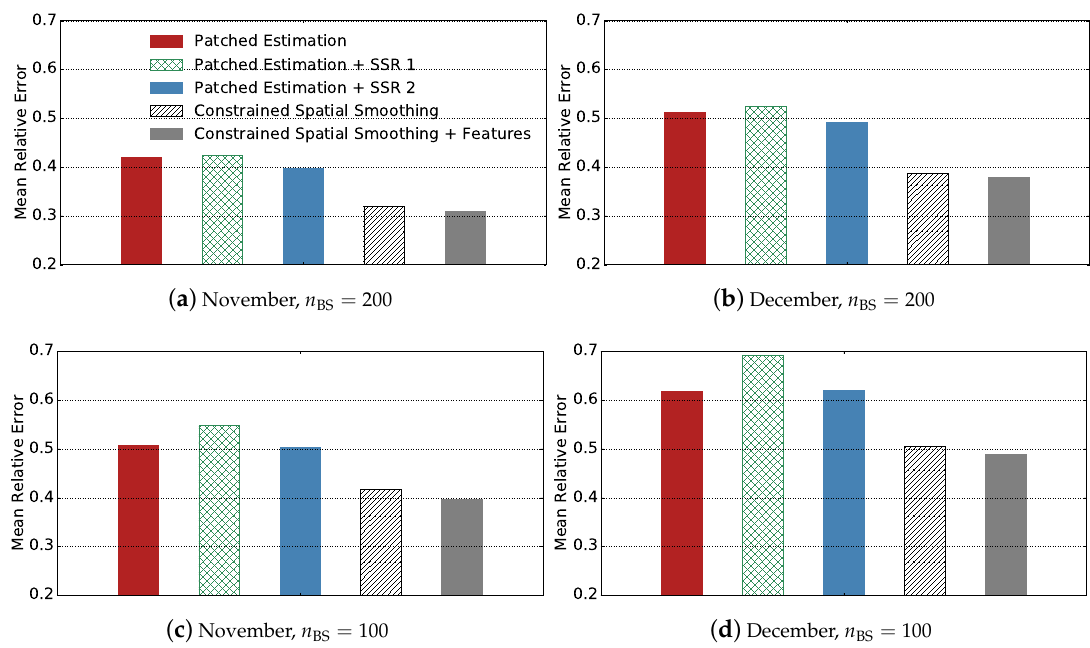
Figure 5. Comparison of the estimation’s Mean Relative Error of different methods when n BS = 200 or n BS = 100 for stress-testing. In each figure, the bars from left to right stands for Patched Estimation, Patched Estimation + SSR 1, Patched Estimation + SSR 2, Constrained Spatial Smoothing, and Constrained Spatial Smoothing + Features respectively. ( a ) we use the data aggregated in November, and set number of base stations to be 200, similarly for ( b – d